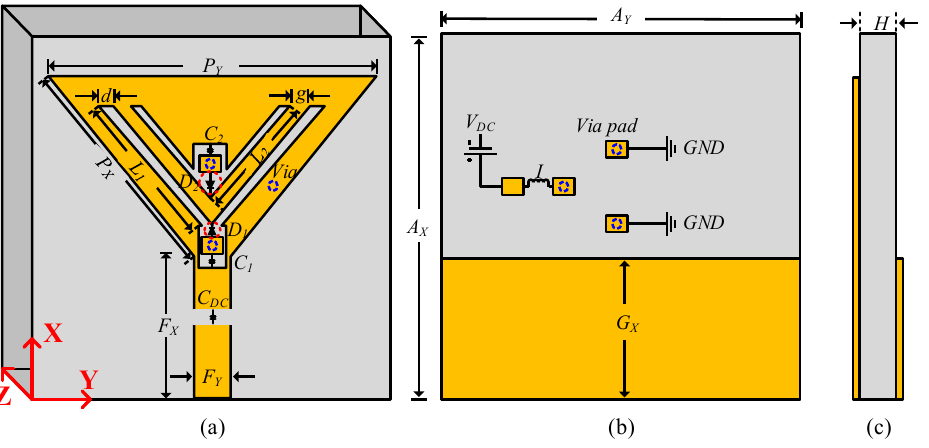
Figure 1. Geometrical configuration of proposed antenna: ( a ) top-view ( b ) bottom-view ( c ) side-view. Table 1. Dimension of the various parameter length of the proposed antenna. Parameter